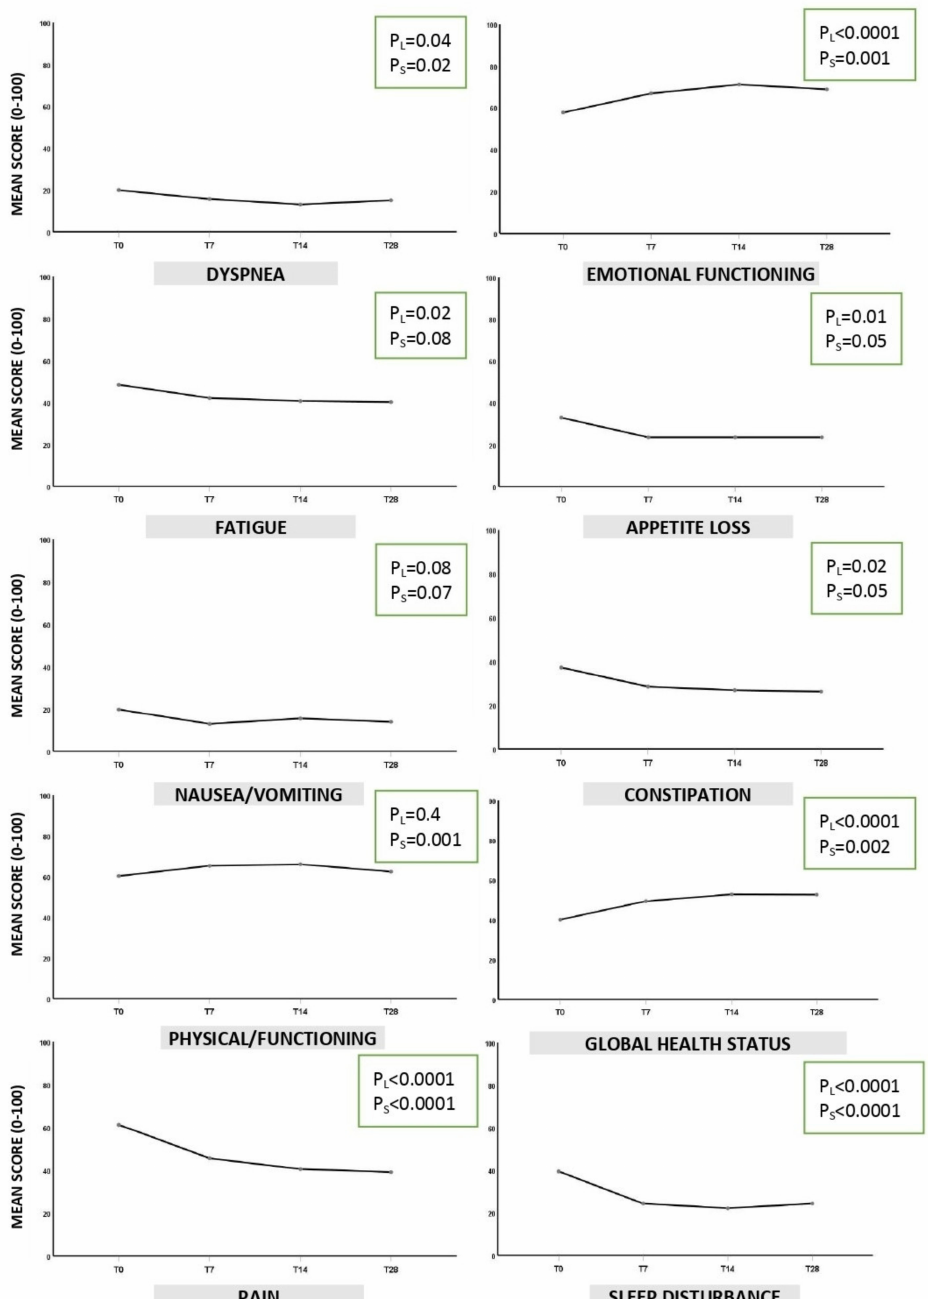
Figure 2. EORTC QLQ-C15-PAL results. Legend: P L = Linear p -value indicates the statistical trend for the 4 visits; P S = square p -value indicates the statistical change from T28 to T0. p < 0.05 was considered statistically significant for